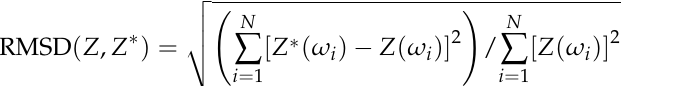
Figure 9. CSA’s impedance signals in a selected range of 22–26 kHz under loading cases. ( a ) z-directional loading. ( b ) x-directional loading.